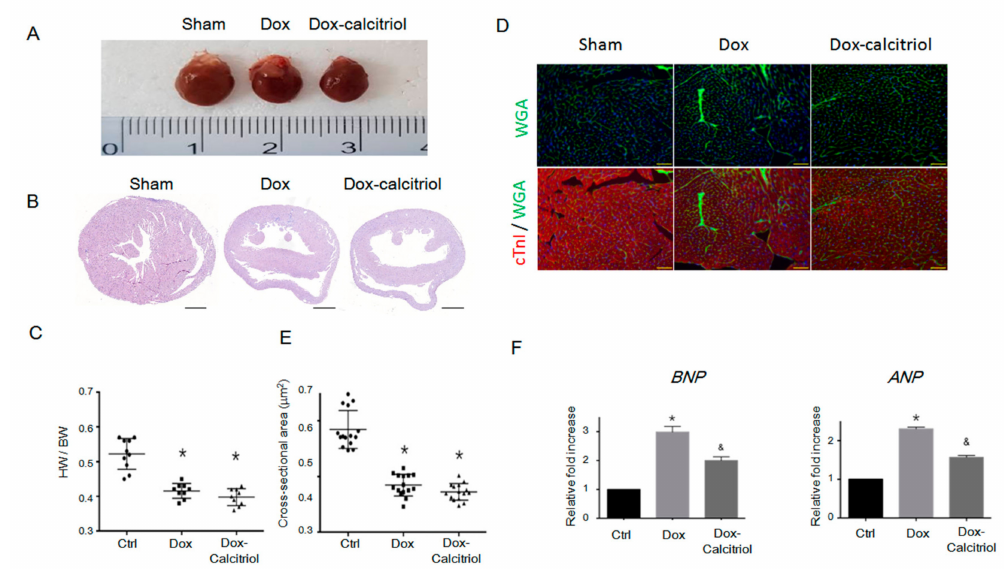
Figure 2. E ff ect of calcitriol on doxorubicin-induced cardiomyopathy. ( A ) Representative gross images of the whole heart. ( B ) Representative images of hematoxylin and eosin (H / E) staining of the ventricular sections. Scale bar: 1000 µ m. ( C ) Quantification of the HW / BW ratio (n = 10 in each group). ( D ) Representative images of labeled WGA (green) and cardiac troponin I (red) staining of the ventricular sections. Scale bar: 20 µ m. N = 3 in each group, 5 high power field (HPFs) per mouse, 15 HPFs total. ( E ) Quantification of the relative myocytes cross-sectional area (n = 3, 100 cells per field, 5 field in each heart). ( F ) Quantitative reverse transcription polymerase chain reaction (qRT-PCR) analyses of the mRNA levels of atrial Natriuretic Peptide (ANP) and brain natriuretic peptide (BNP). Data are normalized to the β -actin content (n = 3). Data are expressed as mean ± SEM, and n represents the number of animals. * p < 0.01, vs. Ctrl; & p < 0.05, vs. Dox. HW: heart weight; BW: body weight; WGA: wheat germ